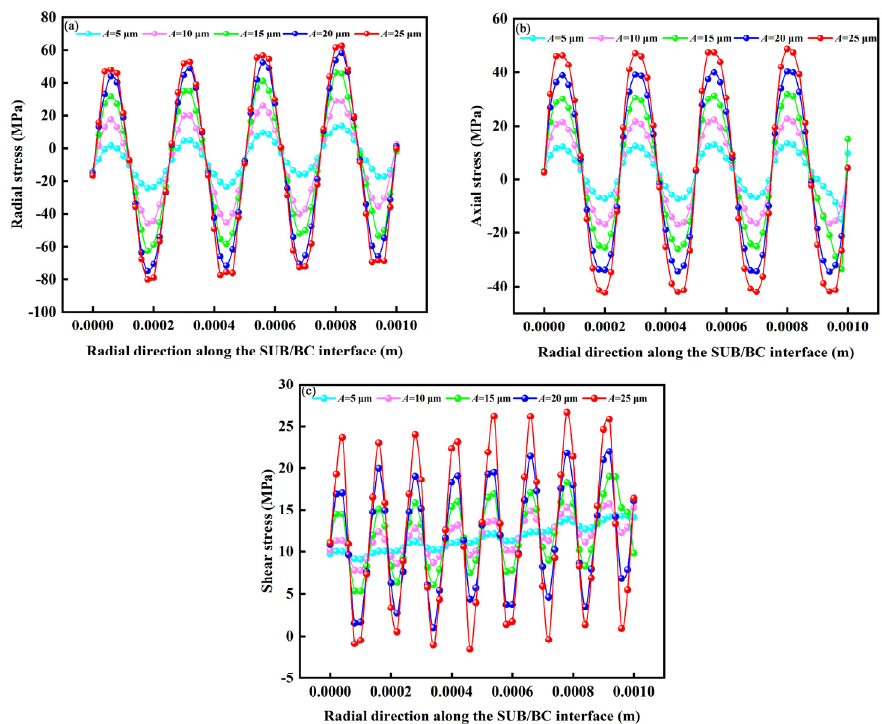
Figure 13. Stress distributions of SUB/BC interface at different amplitudes: ( a ) radial stress; ( b ) axial stress and ( c ) shear stress.